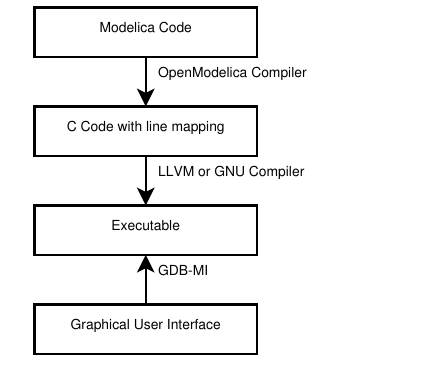
Figure 6: Dynamic debugger flow of control.